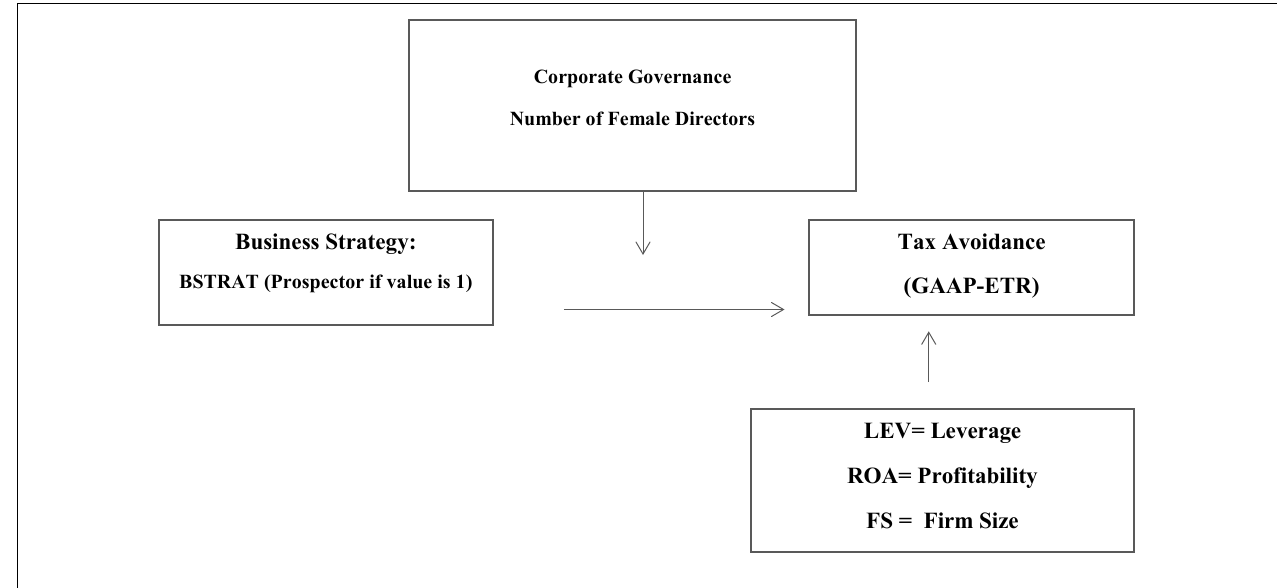
FIGURE 1 | Theoretical framework of study.